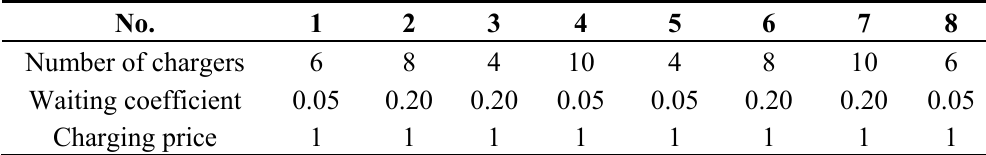
Table 2. Case setting of charging stations.